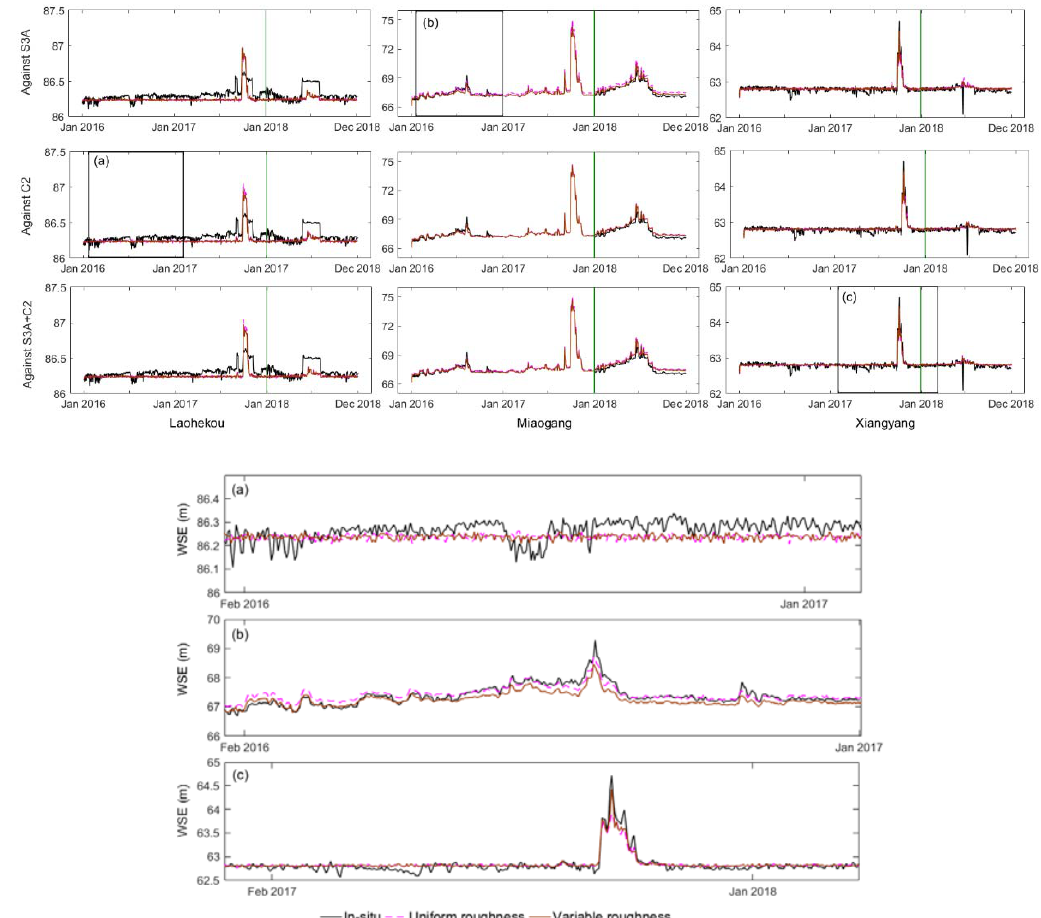
Figure 8. Validation of WSE obtained by configuration B against three in-situ gauging stations. ( a – c ) Zoom-in of the selected WSE simulations.